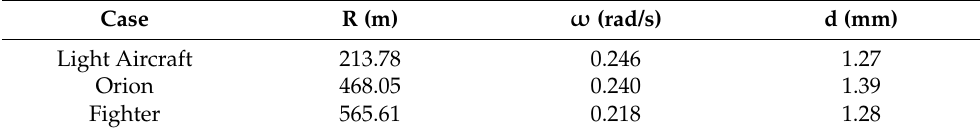
Table 1. Parameters for towed-circular system.